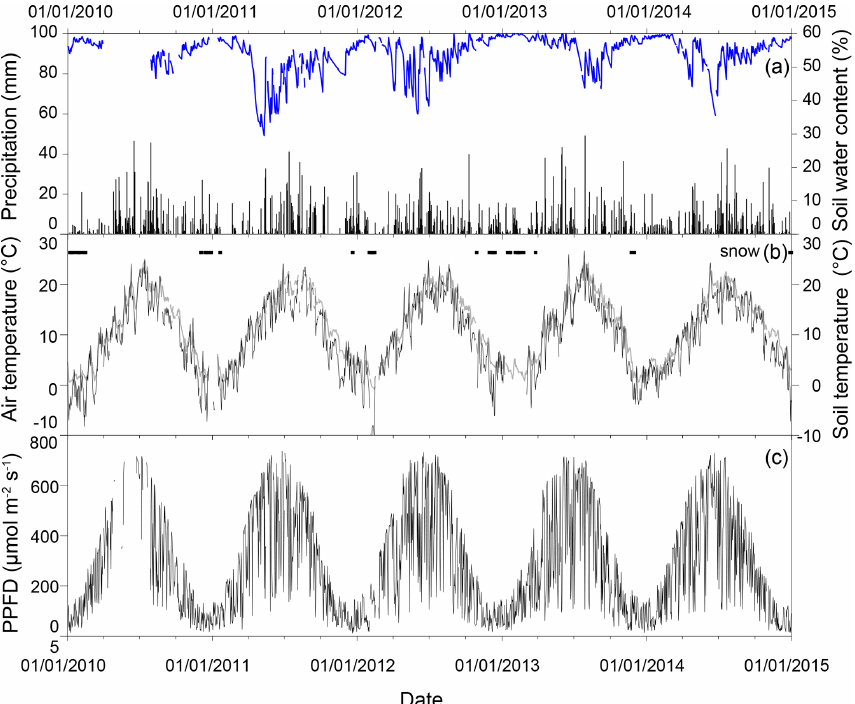
Figure 1. Weather conditions during the years 2010–2014. Weather data were measured with our meteorological sensors installed on-site. (a) Daily sum of precipitation (mm) and soil water content (SWC, blue line, m 3 m − 3 ) measured at 5cm soil depth; (b) daily averaged air temperature ( ◦ C), daily averaged soil temperature (grey line, ◦ C) and days with snow cover (horizontal bars); (c) daily averaged photosyn- thetic photon flux density (PPFD; µmolm − 2 s − 1 ). Days with snow cover were identified with albedo calculations. Days with albedo > 0 . 45 were identified as days with either snow or hoarfrost